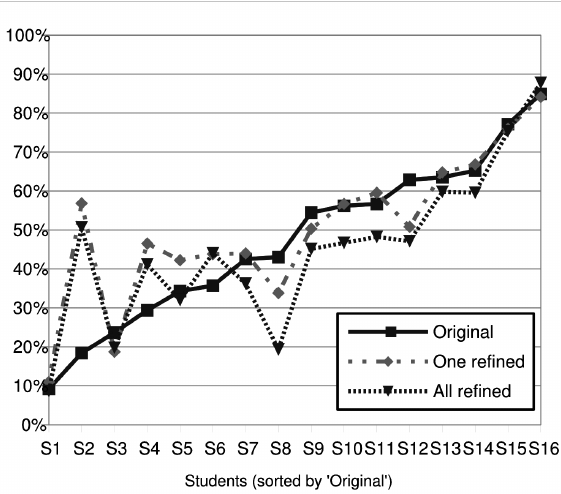
Figure 4. Ratio of achievable points actually obtained by round type for each student in cohort 1.